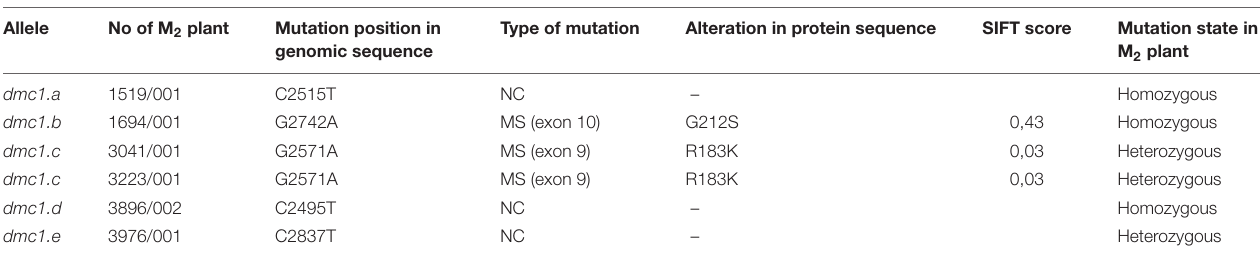
FIGURE 2 | Selection of the HvDMC1 gene fragment for TILLING analysis (A) CODDLE analysis showing the most conserved fragment of the gene (blue line – score missense changes and truncations; violet – the PSSM difference). (B) Comparison of the DMC1 protein sequences from various plant species. The red frame shows conserved fragment of the protein which is encoded by the analyzed fragment of the HvDMC1 gene. TABLE 1 | Characteristics of mutations identified in the HvDMC1